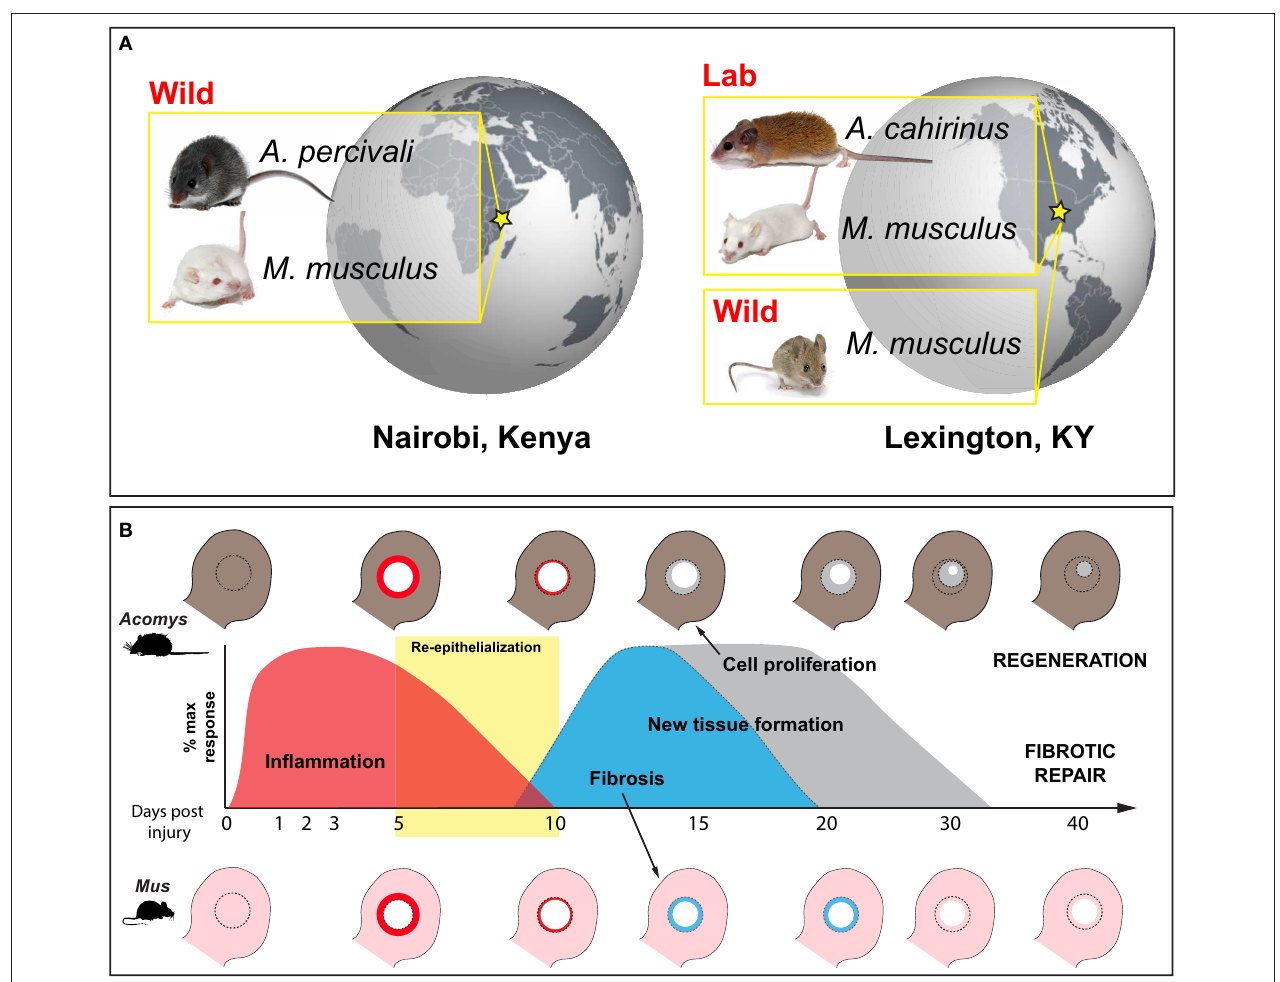
FIGURE 1 | Wild-caught and laboratory-reared animals employed to characterize the immune response to injury during regeneration and fibrotic repair using a comparative ear punch assay. (A) Immune-primed A. percivali (wild-caught) and M. musculus (privately bred) were acquired in Kenya and housed in an open-air facility in Nairobi. A. cahirinus and M. musculus used at the University of Kentucky were captive bred from lab colonies in a clean facility and considered to have naïve immune systems. We also trapped M. musculus in Kentucky. (B) Schematic depicting excision of a 4mm circular hole in the ear pinna (D0) and subsequent regeneration and fibrotic repair in Acomys and Mus, respectively. Local inflammation follows tissue excision and persists until D10 (red) (16, 42). Keratinocyte ∼ activation leads to re-epithelialization between D5 and D10 (yellow box) ( 41, 43). New tissue formation follows re-epithelialization and is characterized by a strong upregulation of extracellular matrix proteins. Matrix production is biased toward collagen production and fibrosis in Mus , leading to scar formation and an open hole (light blue). In Acomys , robust cell proliferation is maintained until the entire hole is filled with new tissue that undergoes morphogenesis to replace all of the original tissue components (e.g., epidermis, dermis, hair follicles, sebaceous glands, cartilage, etc.)